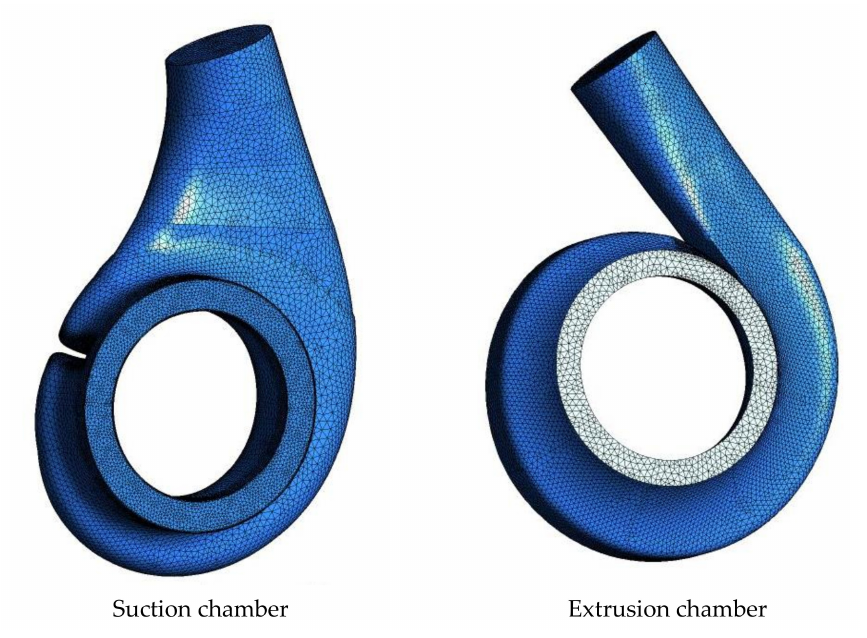
Figure 7. Tetrahedral meshes of the suction chamber and extrusion chamber.